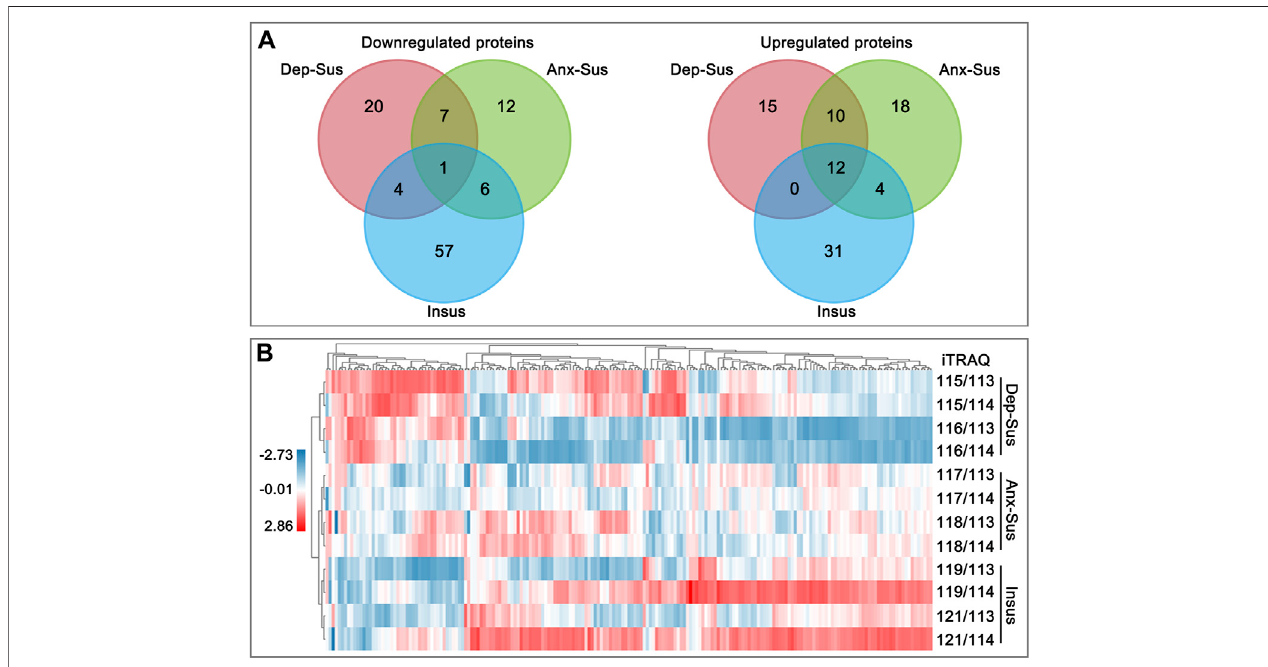
FIGURE 2 | Analysis of the deregulated pituitary proteins identi fi ed in the depression-susceptible (Dep-Sus), anxiety-susceptible (Anx-Sus), and insusceptible (Insus) groups. (A) Venn diagrams of the deregulated proteins in the three stressed groups. (B) Heatmap of the deregulated proteins in the three groups. Higher expressions were indicated by red and lower by blue. The expression levels were shown with various color intensities. In the color bar the log2 scale was